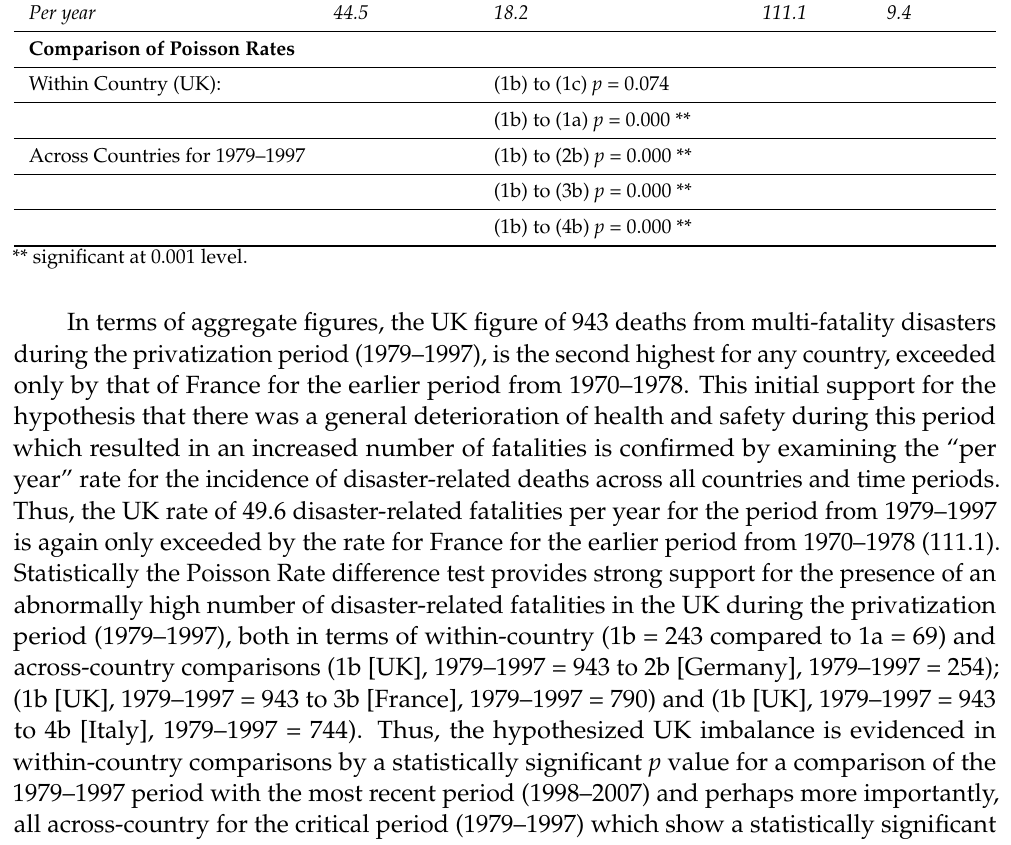
Comparison of Poisson